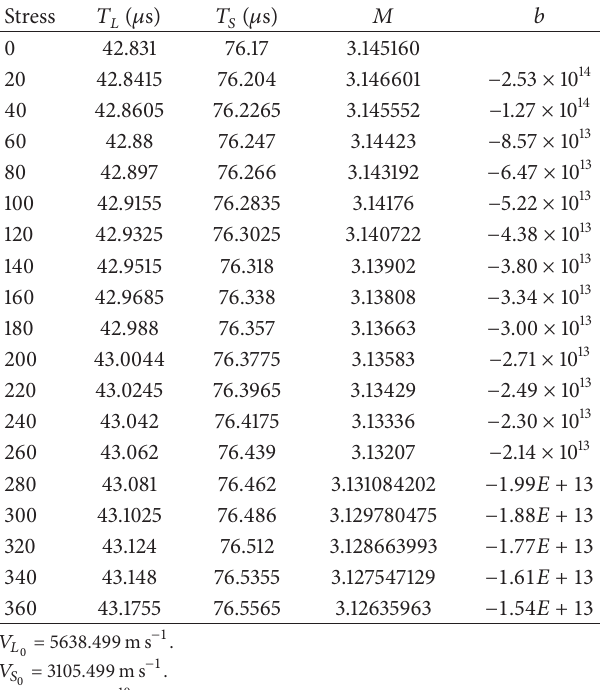
Table 2: Tensile stress measurement results for a low-carbon 4.8 steel bolt.